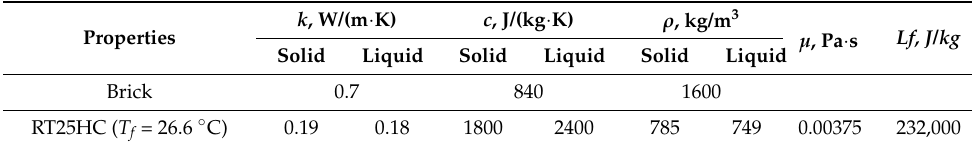
6 of 12 Figure 3. Isotherms Θ and streamlines Ψ for L = 0.02 m and ∆ T = 20° obtained for different grids: solid black line—161 × 101 nodes, solid red line—281 × 176 nodes, dashed line—401 × 251 nodes. 3. Results and Discussion